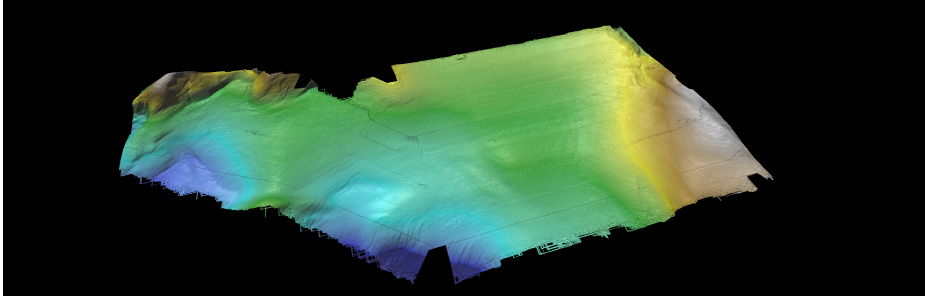
Figure 12. 3D shaded relief of the part of the mapped area at the depth range of 3700–4000